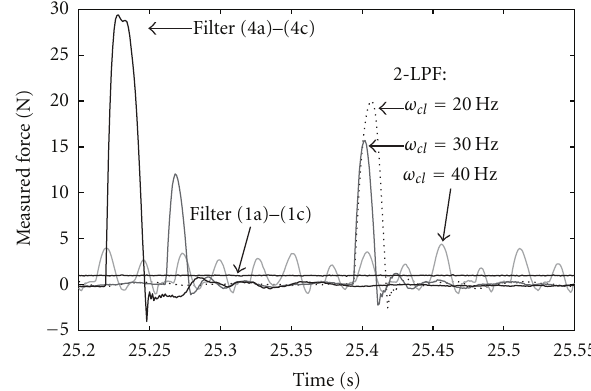
Figure 15: Comparison among filter (1a)–(1c) with F = 65000N / s 2 and α = 3, 2-LPF with ω cl = 20, 30, and 40Hz, and filter (4a)–(4c) with F = 65000N / s 2 and without filter.